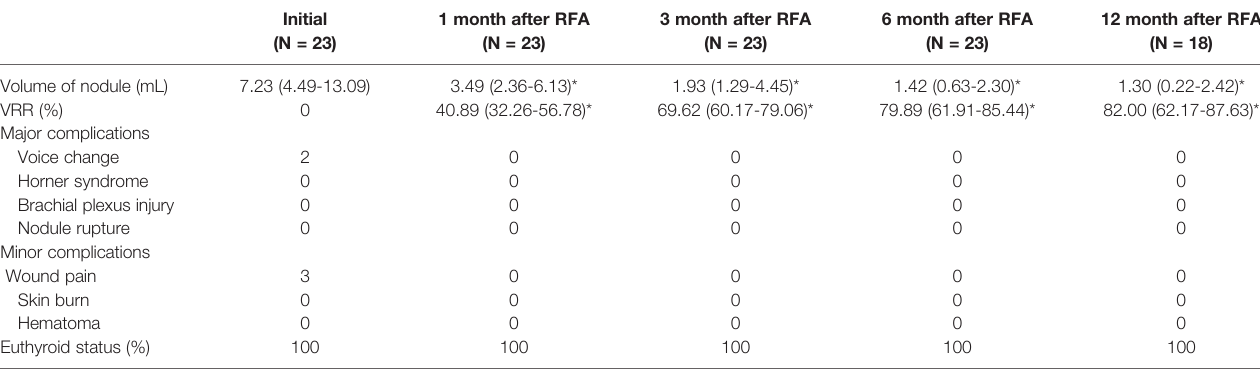
TABLE 2 | Outcomes of main nodules after thyroid radiofrequency